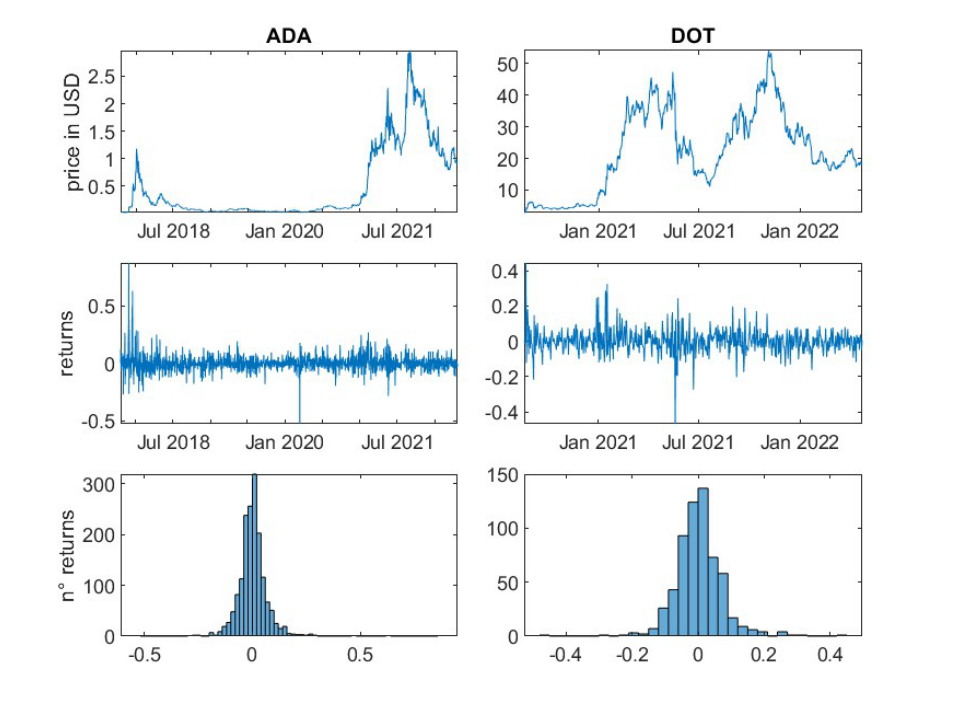
Figure A4. ADA and DOT daily logarithmic returns.